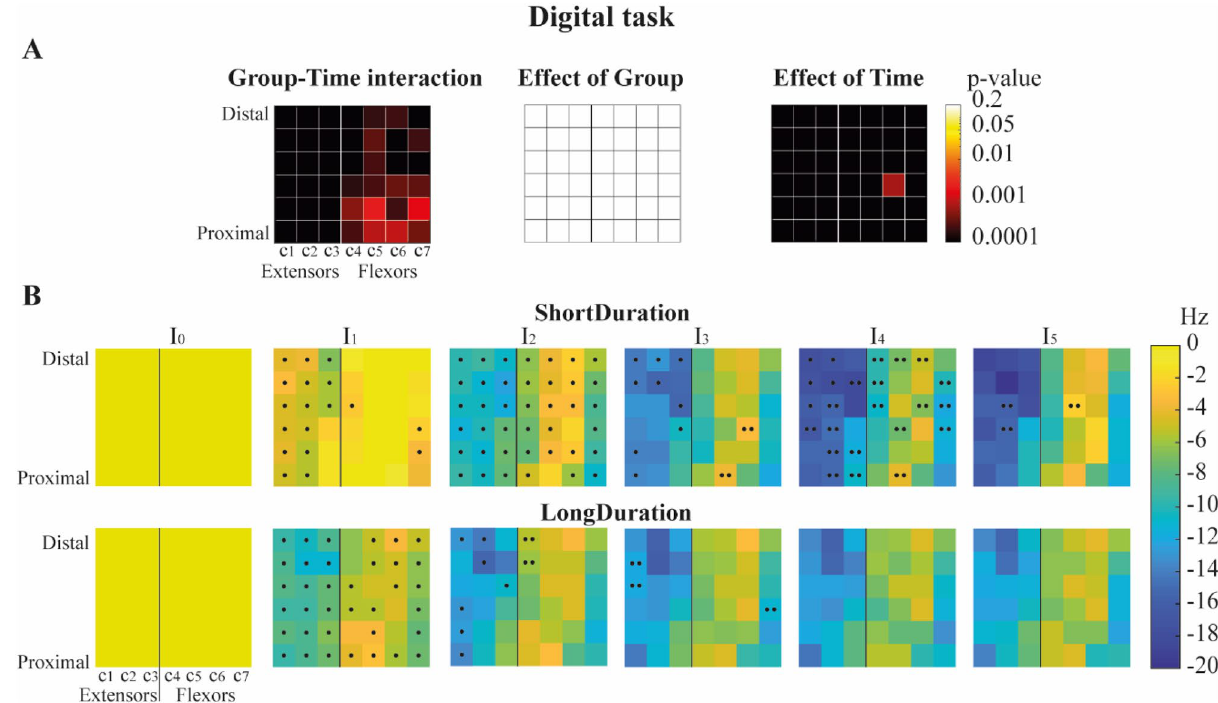
Figure 3. ( A ) colormap representation of ANOVA results’ p values for Group–Time interaction, main effects of Group, and Time for the Digital task. Columns of electrodes are labelled c1 to c7 as illustrated on the Fig. 8B. ( B ) Average change from baseline (I 0 ) representation of the participants’ EMG median frequency of the forearm muscles throughout the duration of the task (I 0:5 ), for the ShortDuration (superior panel) and LongDuration (inferior panel) groups. Note that ANOVA were performed on EMG median frequency values and that variation from baseline was for representation only. Dots indicate significant differences revealed by post-hoc analyses. One dot indicates a significant difference between time intervals I i and I i−1 for a given pair of electrode, while two dots indicates a significant difference between time intervals I i and I i−2 . For example, at time interval I 4 for the ShortDuration group, the dot on the left column ( c1 ) of the top row indicates a significant difference between the EMG median frequency at time intervals I 3 and I 4 , while the two dots on the middle column ( c4 ) of the top row indicates a significant difference between the EMG median frequency at time intervals I 2 and I 4